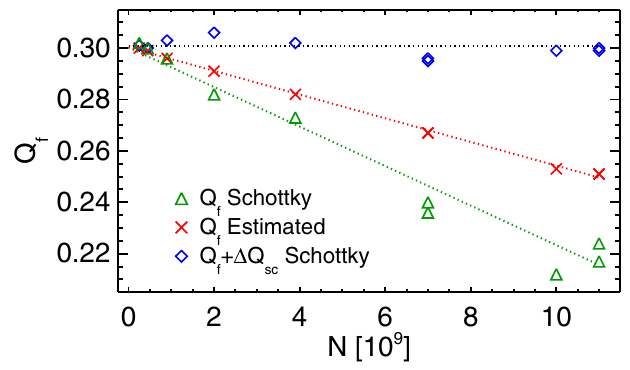
FIG. 7. (Color) Fractional part of the betatron tune Q from the f Schottky measurement (green triangles) and estimation (red crosses) for varying ion number. In addition, the reconstructed þ (cid:1) Q machine tune Q sc is plotted (blue diamonds). As it is f always (cid:4) Q (horizontal line), only space charge is responsible f; 0 for the deformation. The nonhorizontal lines are least mean square fits to the effective